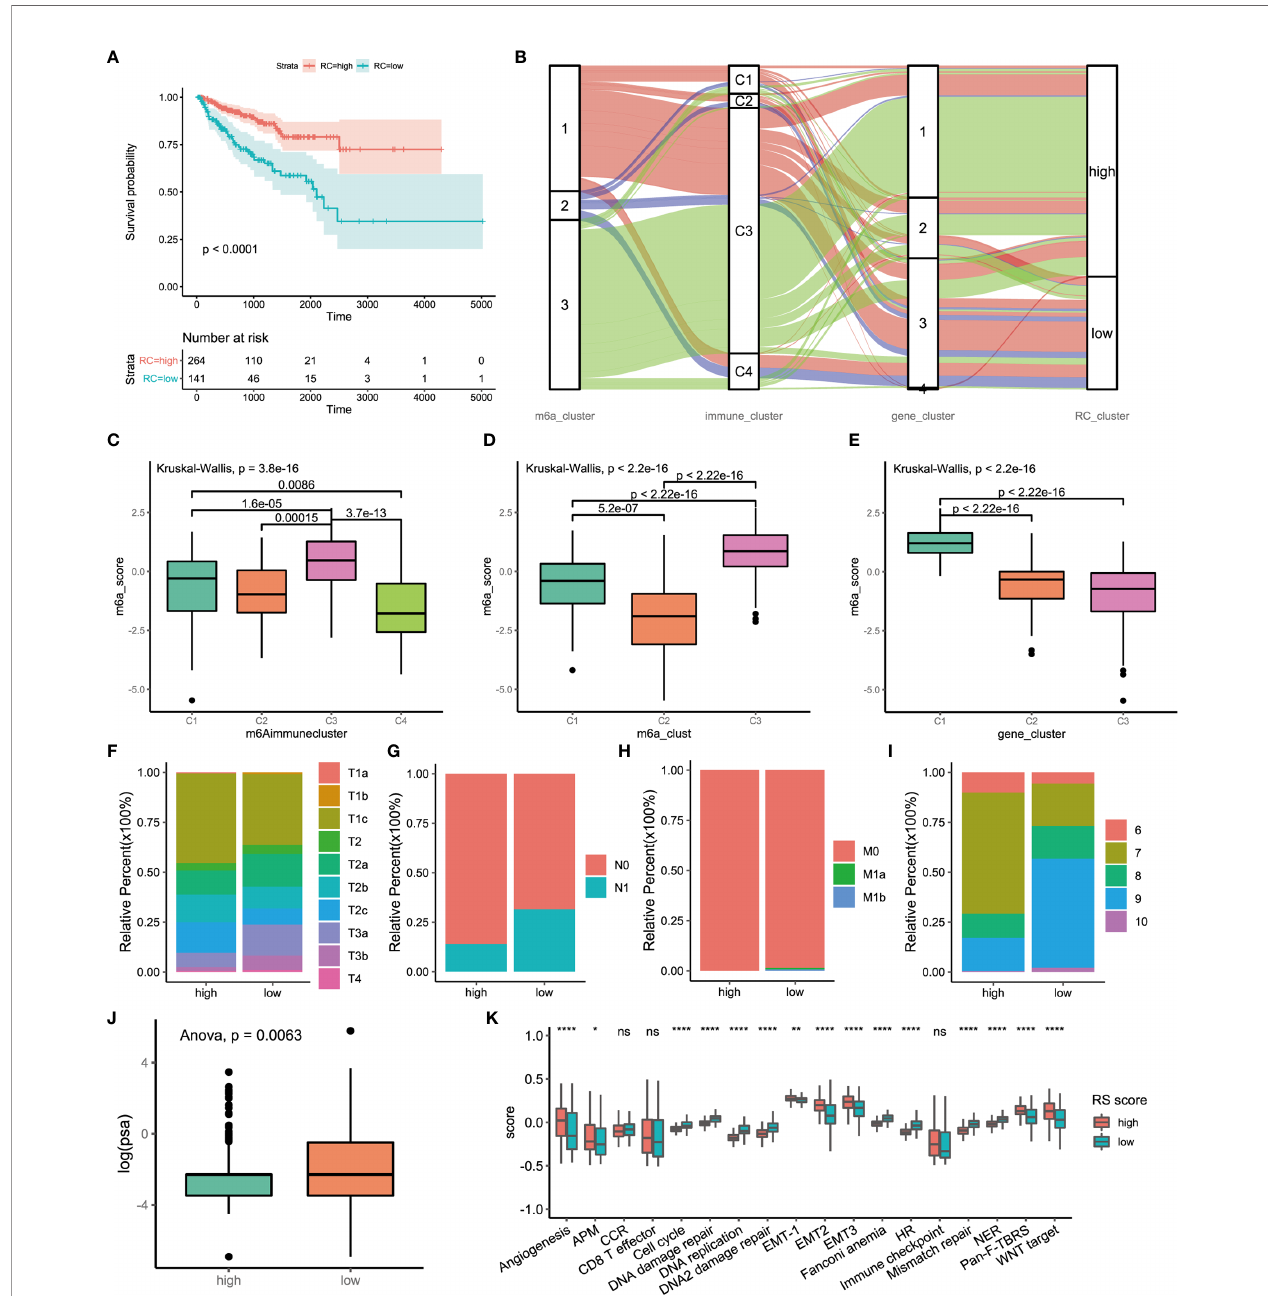
FIGURE 5 | Construction of m6A signatures. (A) Survival analyses for low (264 cases) and high (141 cases) m6A risk score patient groups using Kaplan-Meier curves (P < 0.0001, Log-rank test). High risk score group is better than low risk score group. low risk scoring group has a higher risk. (B) Alluvial diagram represented the changes of m6A regulators clusters, immune clusters, differential genes clusters and risk score clusters of the prostate cancer samples. (C) Differences in m6Ascore among different immune subtypes. (D) Differences in m6Ascore among different m6A regulators clusters. (E) Differences in m6Ascore among different m6A associated difference genes clusters. (F) Differences in primary tumor stage between high and low risk score groups. (p=0.015) (G) Differences in regional lymph node metastasis between high and low risk score groups. (p=0.001) (H) Differences in distant metastasis between high and low risk score groups. (p=0.1652) (I) Differences in Gleason score between high and low risk score groups. (p=0.005) (J) Differences in PSA between high and low risk score groups. (p=0.001) (K) The score of tumors associated signature between high and low risk scores groups. high risk score group, red. low risk score group, green. The upper and lower ends of the boxes represented interquartile range of values. The lines in the boxes represented median value, and black dots showed outliers. The asterisks represented the statistical p value (*P<005; **P<001; ****P<0.0001); ns, not statistically signi fi cant. APM, Antigen processing machinery; CCR, Cell cycle regulators; HR, Homologous recombination; NER, Nucleotide excision